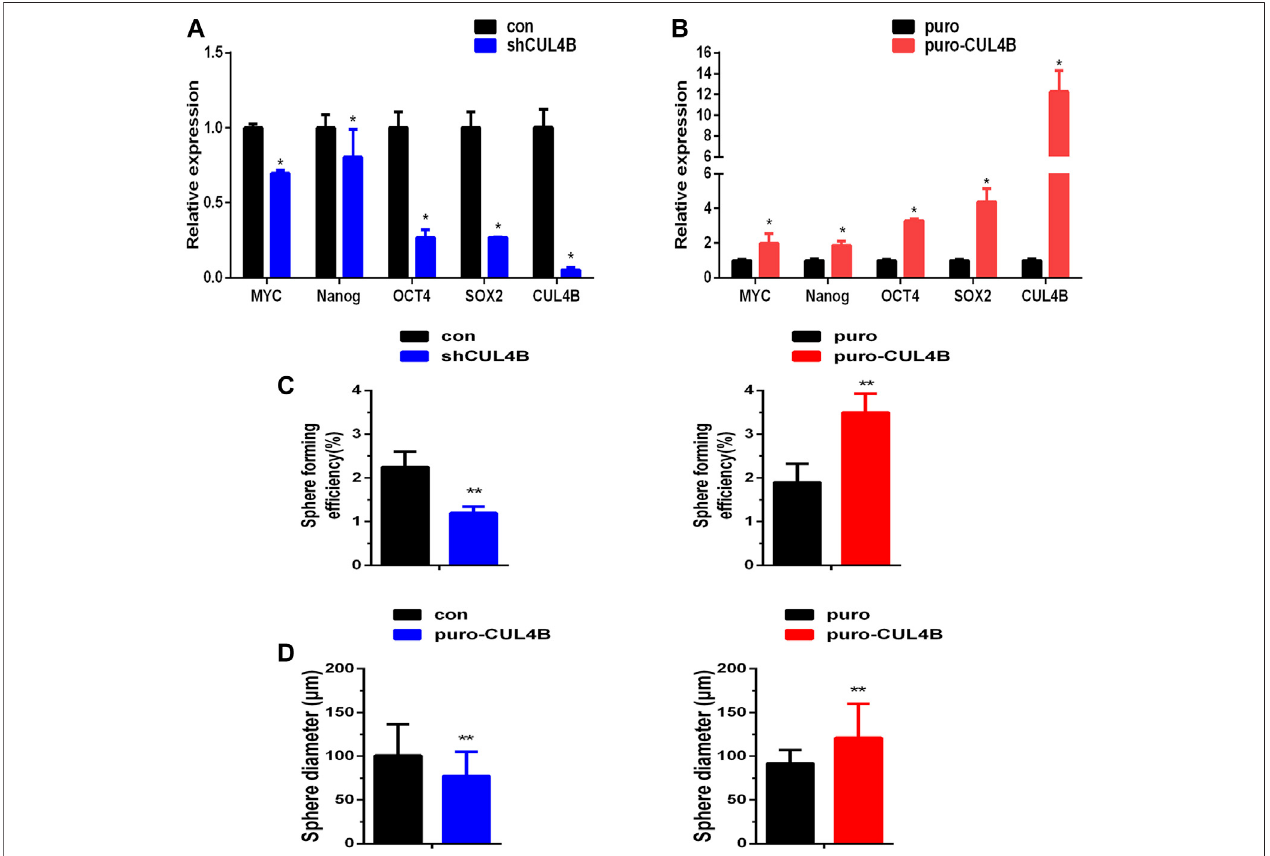
FIGURE2| CUL4BenhancesstemnessofPDLSCs. (A,B) ExpressionlevelsofstemnessmarkersasindicatedinCUL4Bstablyoverexpressing(puro-CUL4B), (A) and knockdown [shCUL4B, (B) ] PDLSCs together with corresponding control cells (puro or con) analyzed by qRT-PCR . (C,D) Representative bar graph of the percentages of spheres (C) and the diameter of the spheres (D) in CUL4B stably overexpressing (puro-CUL4B) and knockdown (shCUL4B) PDLSCs together with corresponding control cells (puro or con). Scale bars: 200 μ m. All quanti fi cation analyses were based on independent triplicate experiments. Error bars represent SD. Statistical comparisons were made using a two-tailed unpaired t-test, * p < 0.05, ** p < 0.01 compared with the negative control.